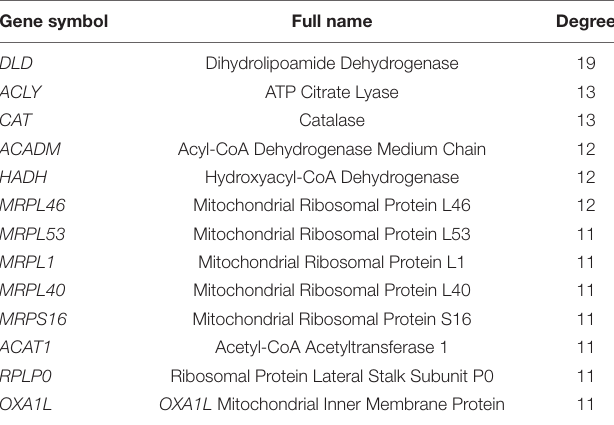
TABLE 2 | Hubs in the PPI